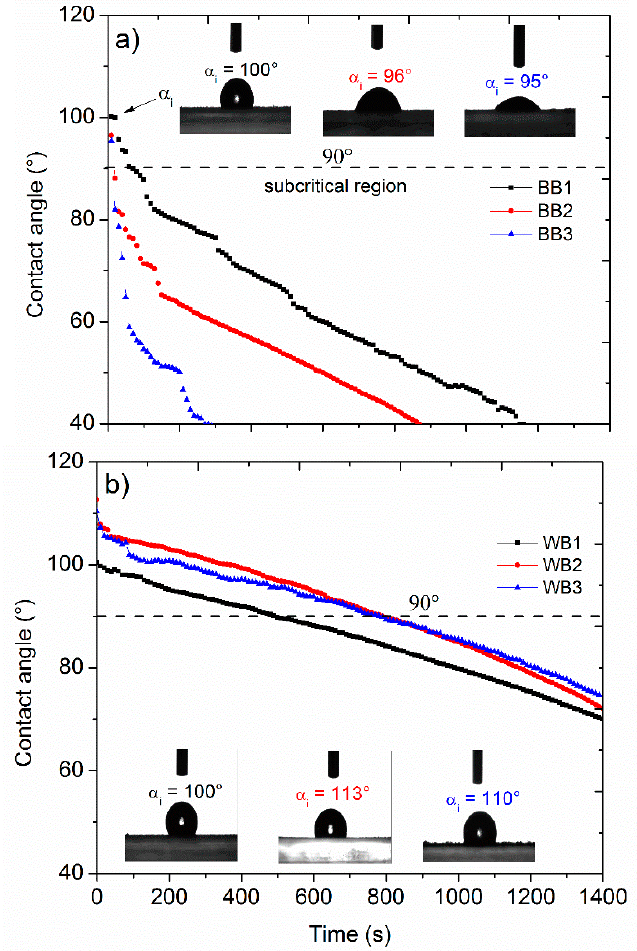
Figure 3. Hydrophobicity analysis by sessile drop method (SDM) of ( a ) bamboo biochars, BB and ( b ) pinewood biochars, WB. The drop size was 2 µL. Notice that initial contact angle was determined at initial time.